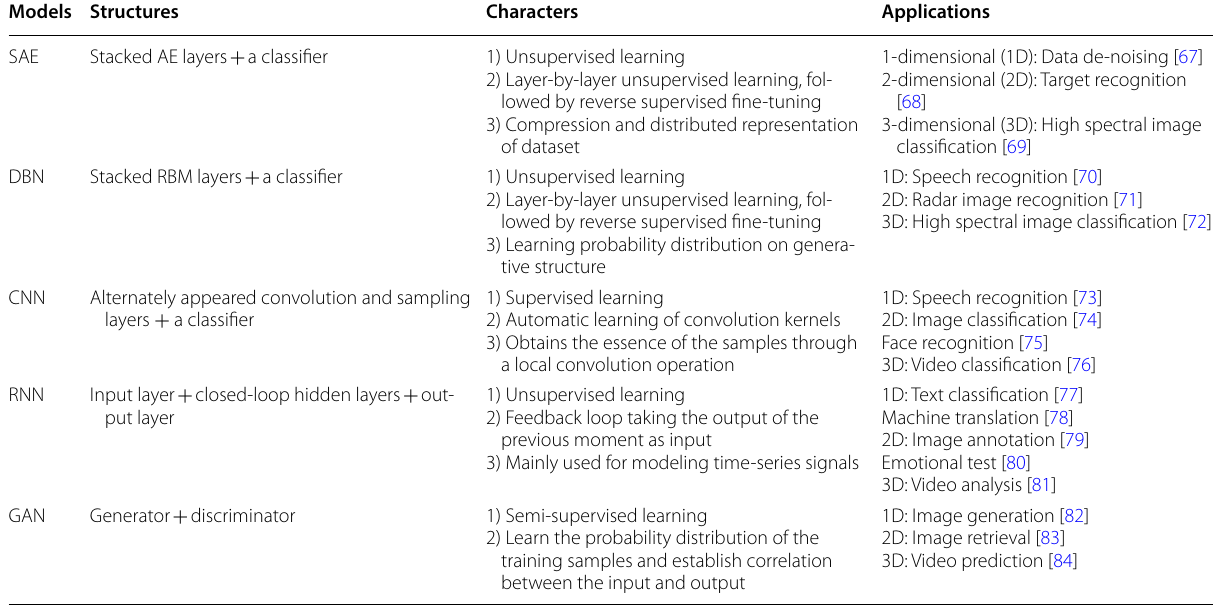
Table 1 Summary and induction of typical DNNs Models Structures